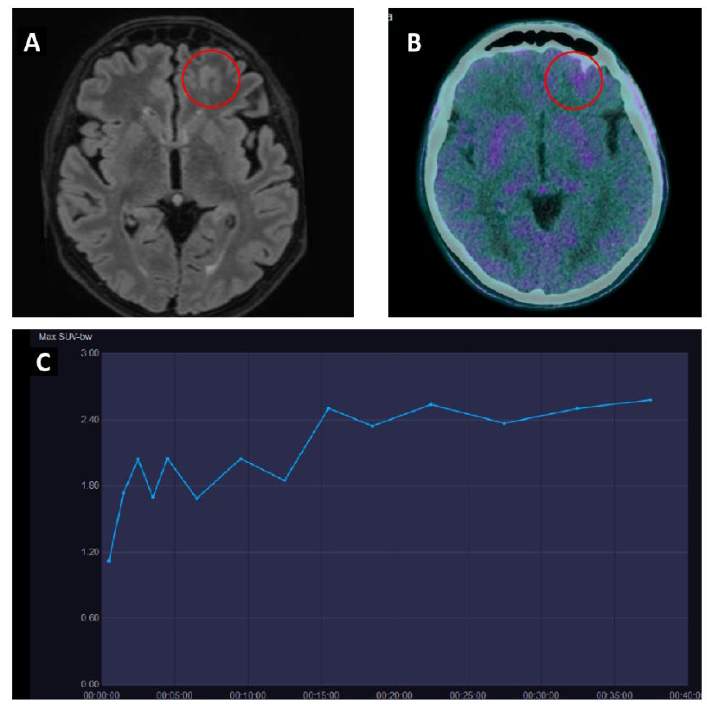
Figure 2. Patient with breast cancer and suspected recurrence of BM after radiotherapy. ( A ) Brain MRI shows an area of hyperintense TR signal on left frontal-orbital cortex (red circle). ( B ) Static [ 18 F]-FET PET/CT demonstrated only a slight [ 18 F]-FET uptale (SUVmax 2.6; TBRmax 1.8) (red circle). ( C ) Dynamic time-activity curve of [ 18 F]-FET PET/CT shows an ascending pattern with a late time to peak (>20 min). PET/CT suggested a treatment related change and patient is still free from disease approximately one year after